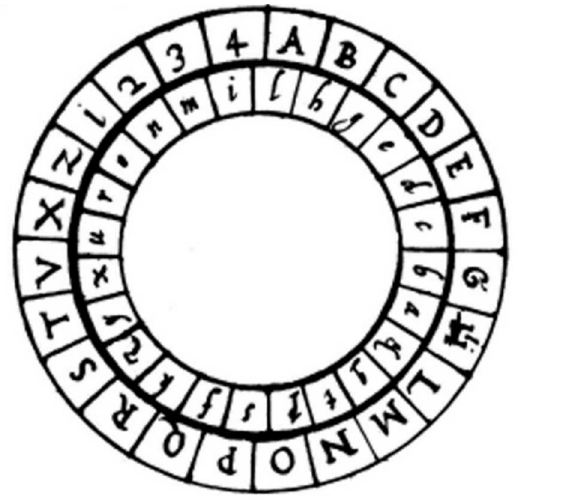
Figure 12. Alberti’s cipher disc from 1466